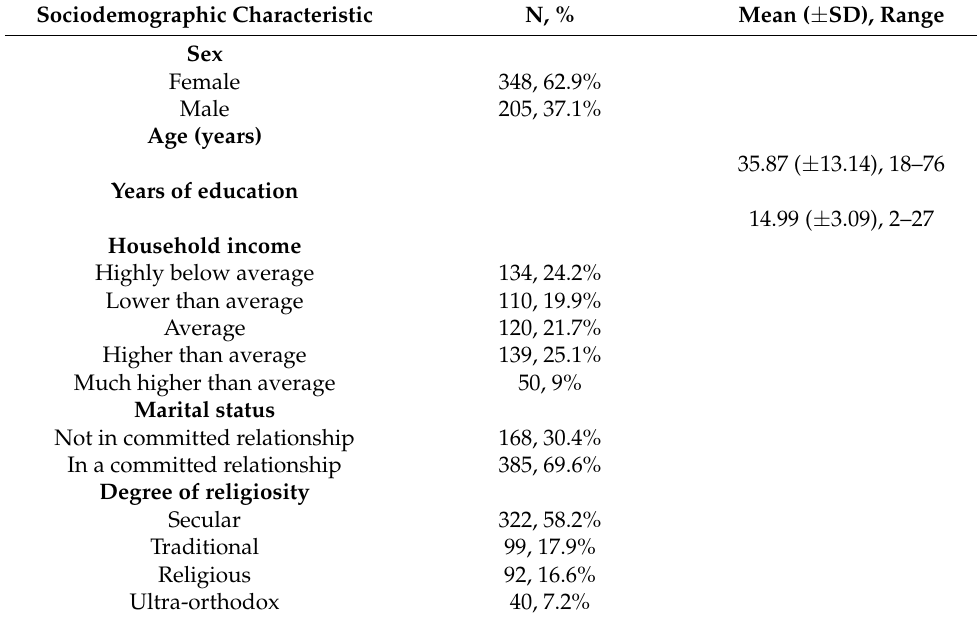
Table 1. Descriptive presentation about basic sociodemographic data among current study partici- pants ( n =